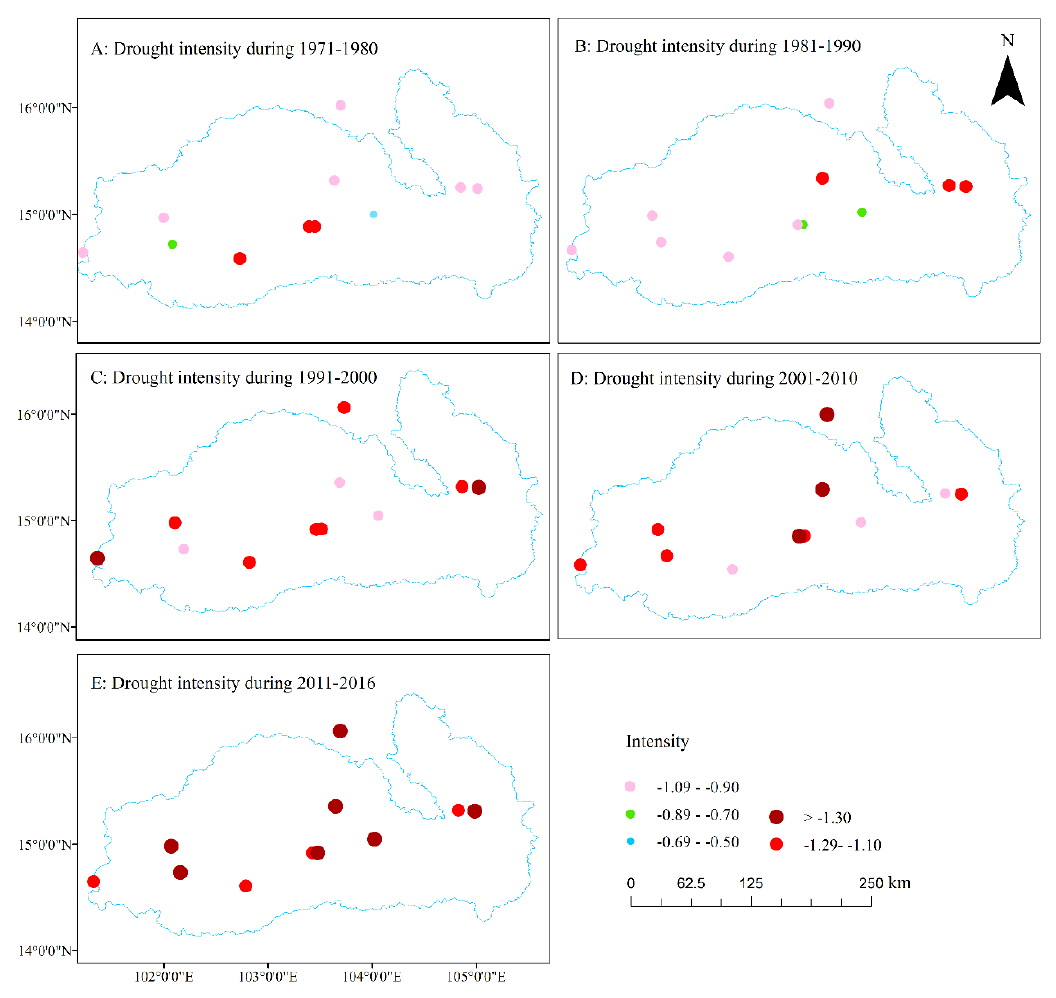
Figure 4. Spatial distribution of drought intensity for every 10 years during the period of 1971–2016 based on SPEI_3M: ( A )1971–1980, ( B )1981–1990, ( C )1991–2000, ( D ) 2001–2010, and ( E ) 2011–2016. By comparing the spatial distribution of the drought intensity of the 1970s with that of the 1980s, we found that the higher-intensity droughts moved to the downstream area from the middle reaches of the Mun River Basin. In the 1990s, the most higher-intensity drought events occurred over the frontier area, while they shifted from the frontier area to the center area in the 2010s. After 2010, the high-intensity droughts attacked the whole Mun River Basin (Figure 4E). Based on a monthly SPEI of < − 0.5 of all stations, we constructed a drought intensity time series from 1971 to 2016 over the Mun River Basin (Figure 5A). The drought intensity series showed an increasing trend and had obvious inter-decadal characteristics. During the period of the 1970s to the 1980s, the drought intensity ranged from 0.66 to 1.14. The drought intensity subsequently increased by 16.4% in the 1990s in comparison to that in the 1980s. The drought intensity reached the highest value of 1.06 after 2010. In addition, the amplitude of the drought intensity fluctuated severely after 1998, indicating that there were more extreme drought events during this period.